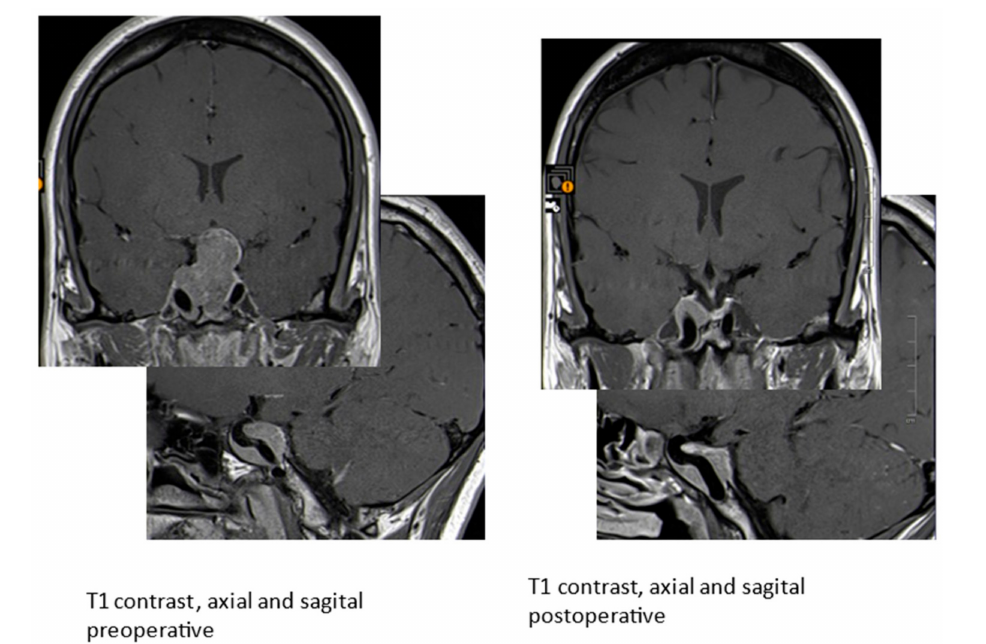
Figure 4. MRI of the sella T1 with contrast media, axial and sagital pre- and postoperative: the tumor encloses the carotid arteries; close to the arteries, remnants had to be left (patient